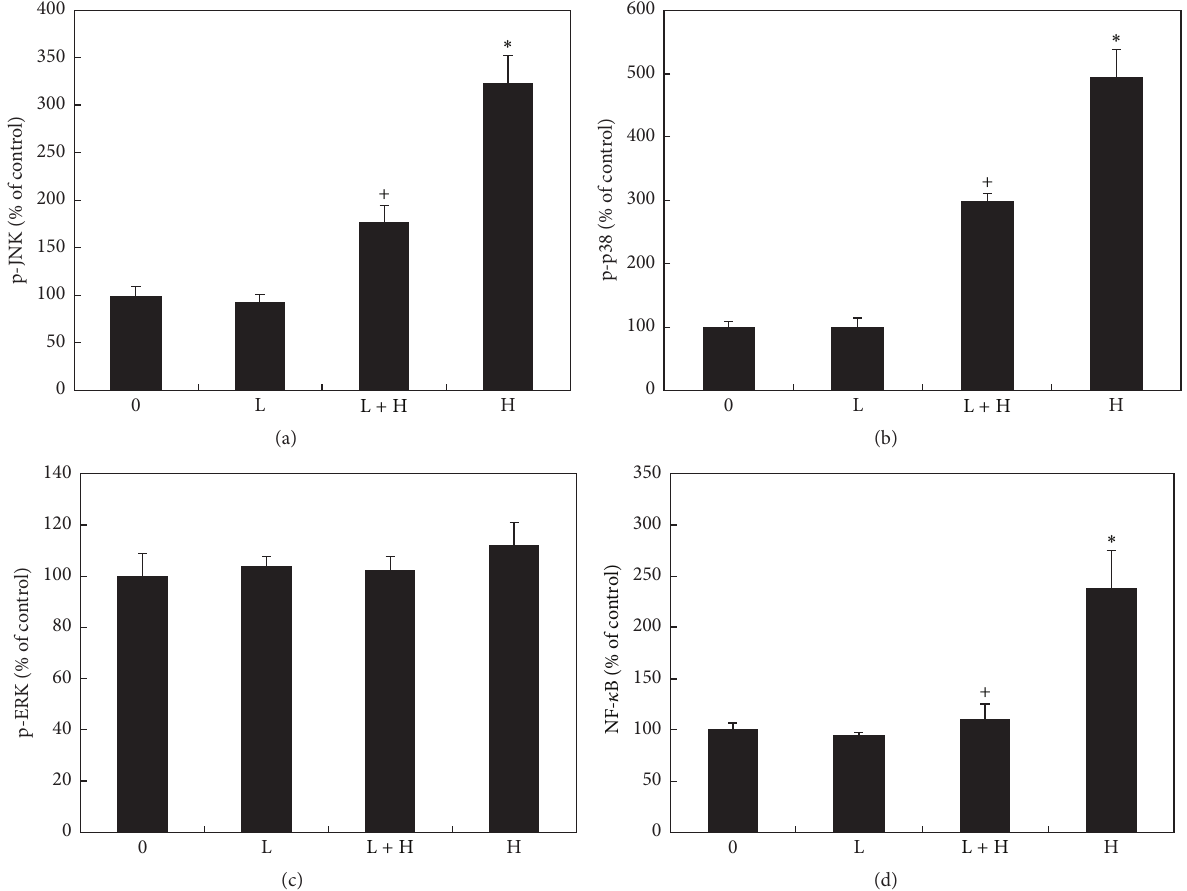
Figure 3: Effects of lutein and hyperosmotic medium on various signal pathways levels of cultured CE cells. Cells were cultured with isoosmotic medium (0) or hyperosmotic medium (H) at 450 mOsM with or without lutein at 10 𝜇 M (L). Cells were collected and the levels of phosphorylated- (p-) JNK (a), p-p38 (b), and p-ERK (c) in cell lysates and NF- 𝜅 B in cell nuclear extracts (d) were measured using relevant ELISA kits, respectively. Hyperosmoticity caused a significant increase of p-p38, p-JNK, and NF- 𝜅 B levels ( ∗ 𝑃 < 0.05 ) but not p-ERK levels. Lutein did not affect any pathways levels in cells cultured with isoosmotic medium. In cells cultured with hyperosmotic medium, lutein significantly reduced p-p38, p-JNK, and NF- 𝜅 B levels ( + 𝑃 < 0.05 ) but not p-ERK1/2 levels as compared to cells cultured with hyperosmotic medium but without